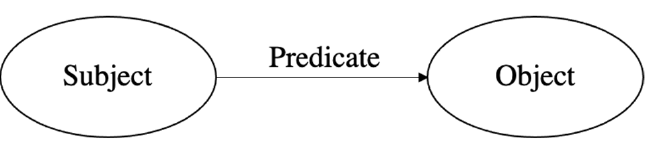
Figure 1. Basic RDF triple.